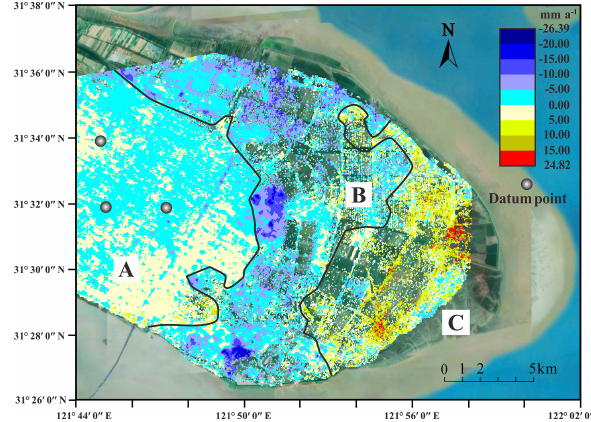
Figure 4. Mean deformation velocity map superimposed on the © Google Earth